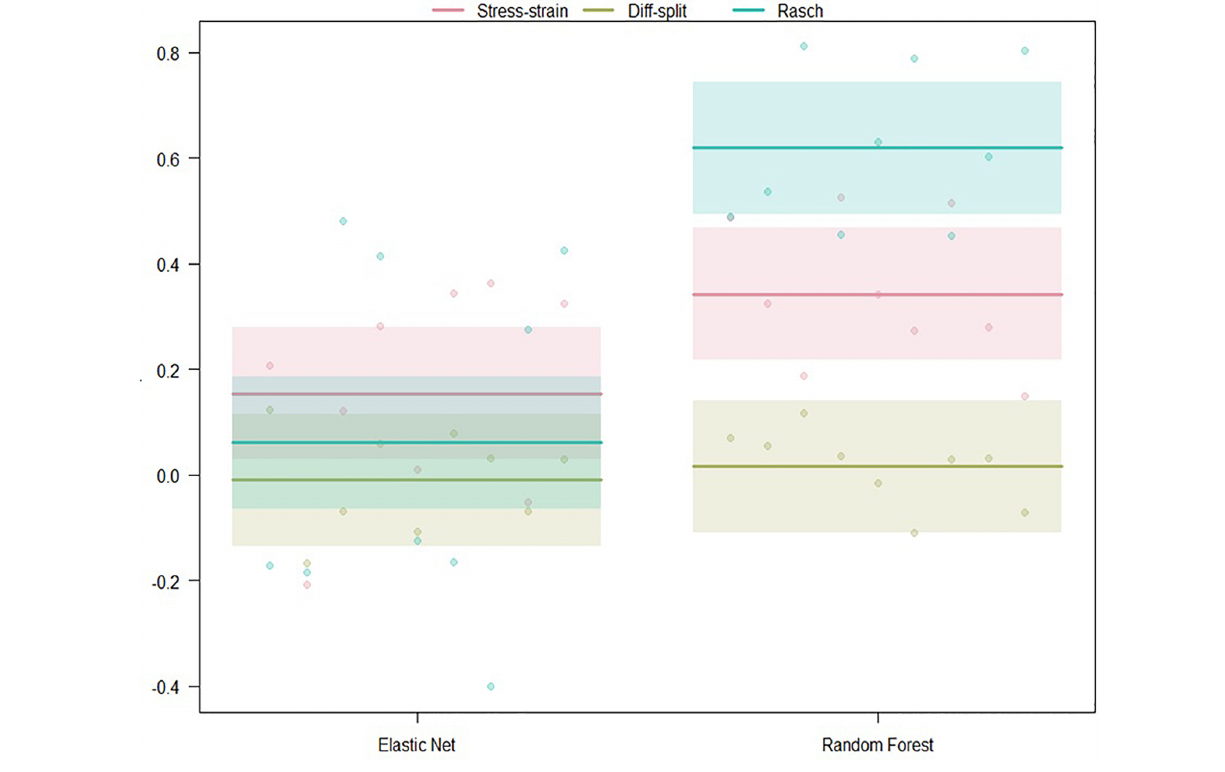
Frontiers in Human Neuroscience |